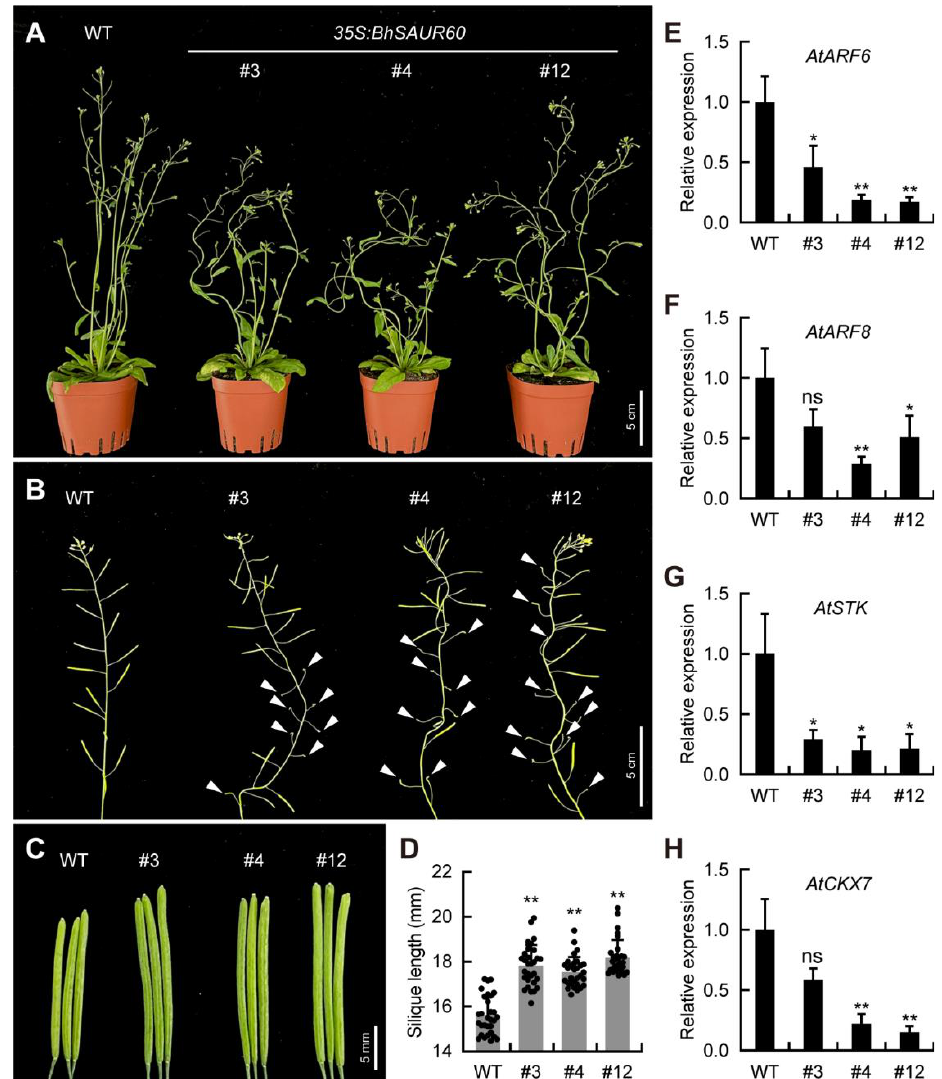
Figure 8. Overexpression of the BhSAUR60 gene in Arabidopsis . ( A ) Whole-plant phenotypes of wild- type (WT) and 35S:BhSAUR60 plants around 10 days after bolting (DAB); ( B ) main-stem phenotypes of WT and 35S:BhSAUR60 plants at 18 DAB. Triangles indicate unfertilized pistils; ( C ) mature siliques of WT and 35S:BhSAUR60 plants; ( D ) silique lengths of WT and 35S:BhSAUR60 plants. Values are means ± SDs ( n = 30), **, p < 0.01 (Student’s t -test); ( E – H ) expression analysis of fruit development-related genes in WT and 35S:BhSAUR60 siliques. Values are means ± SDs ( n = 3), ns, not significant, *, p < 0.05, **, p < 0.01 (Student’s t -test).